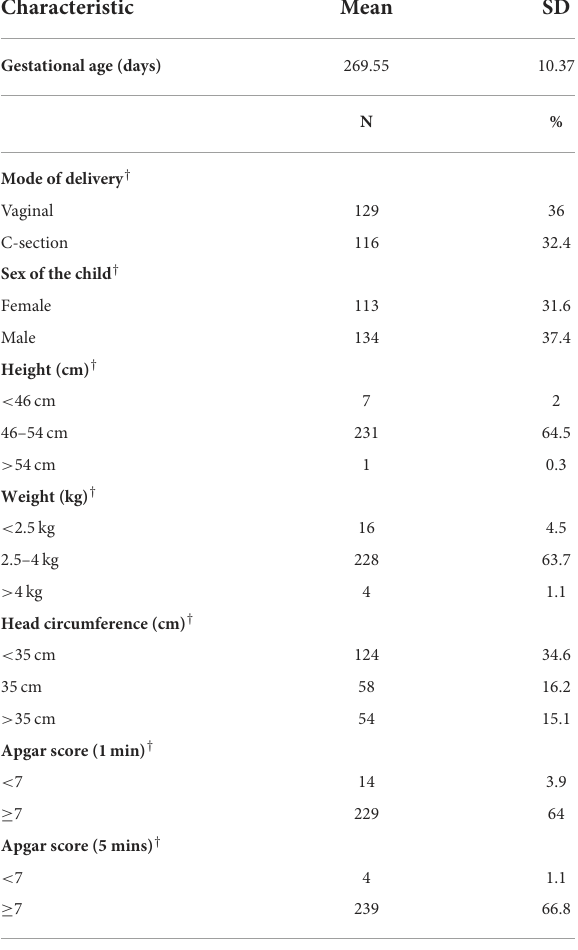
TABLE 2 Descriptive characteristics of neonatal outcomes of the participants (N = 248 †